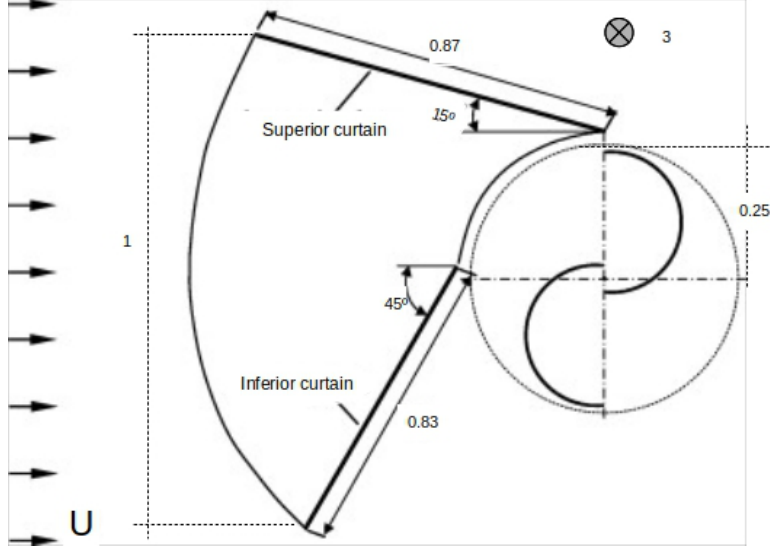
Figure 5. Adapted figure of the optimum design using curtain vanes